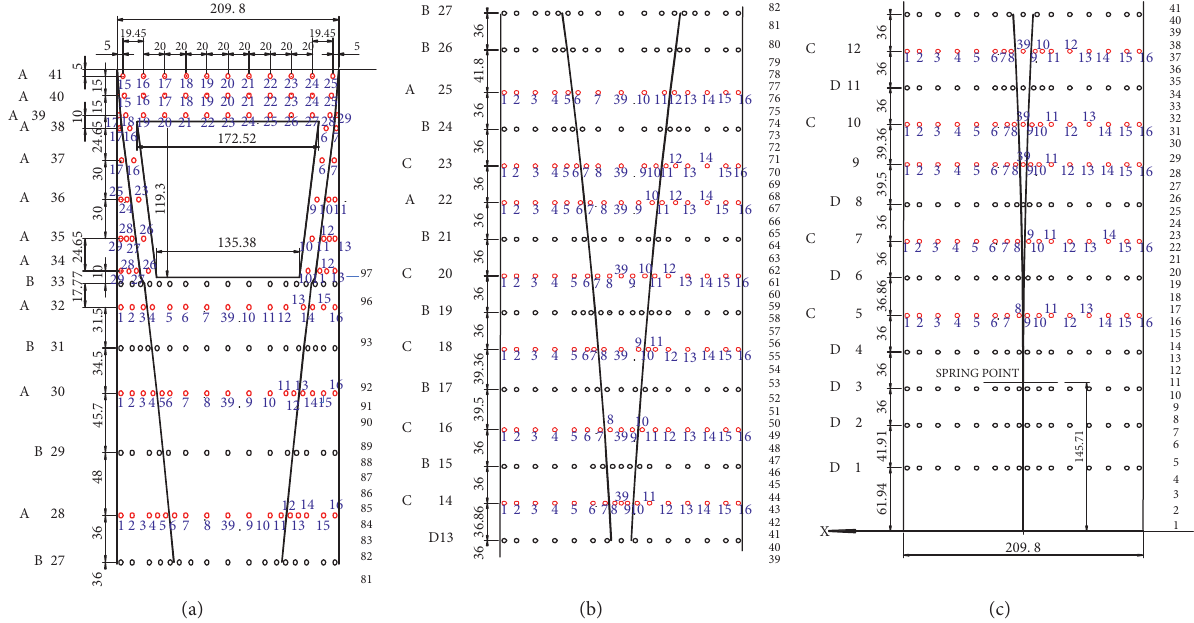
Figure 10: Layout of pressure measuring points on the front elevation of experimental measuring points (only A and C People’s Republic of China (GB50009 － 2001) are shown in Figure 8.